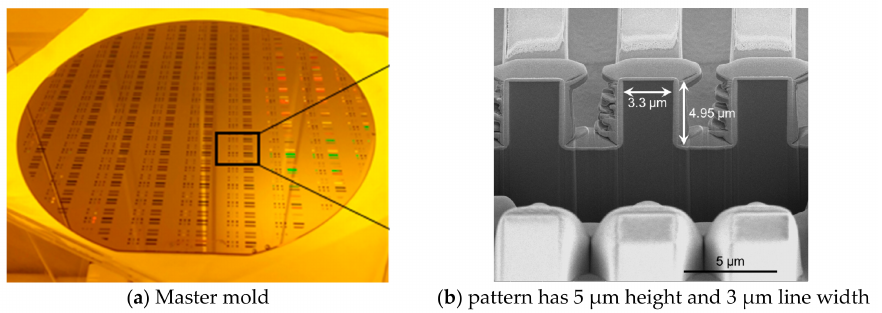
Figure 1. Silicon master mold with a line and space pattern for the UV-NIL process to fabricate the clich é .